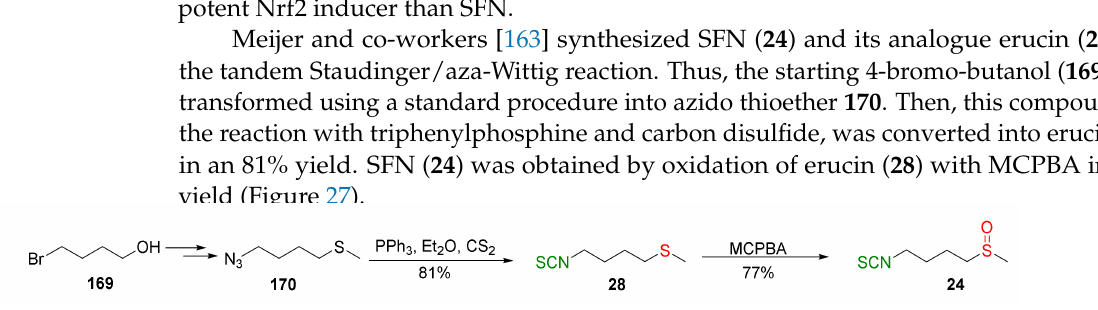
Figure 27. Synthesis of SFN and erucin via Staudinger/aza-Wittig reaction. Studies on P. aeruginosa show that SFN and erucin strongly inhibit quorum sensing (QS) and virulence (biofilm formation and pyocyanin production). The assays on P. aeruginosa and in E. coli strongly indicate that SFN and erucin effectively bind LasR, resulting in inhibition of QS activation at concentrations that can be found in